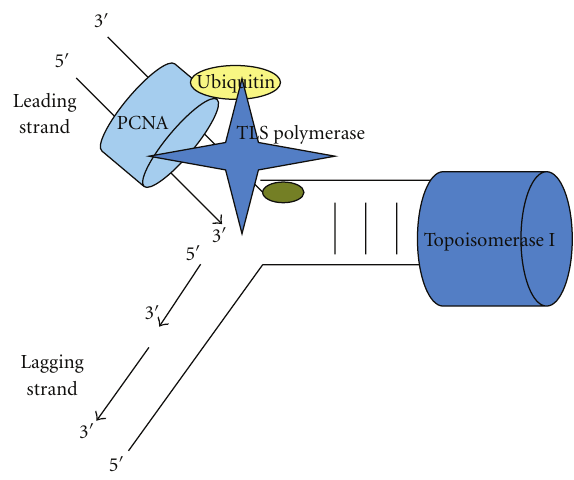
Figure 1: Fork stalling results in monoubiquitylation of the replica- tion clamp PCNA which increases its a ffi nity to a TLS polymerase. The latter replaces the high-fidelity replicative polymerase and it can accommodate the lesion even with the risk of generating mutations in certain circumstances. This Polymerase binds PCNA through its PIP box and a ubiquitin binding